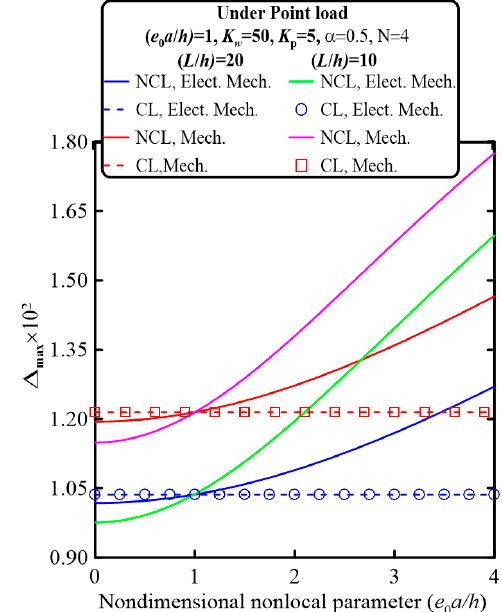
Figure 9. Variation in the maximum normalized transverse deflection Δ max with the nondimensional nonlocal parameter ( e 0 a / h ) for nonclassical and classical electromechanical and mechanical behaviors under uniformly distributed and point loads at different values of the nonclassical and elastic foundation parameters at α = 0.5 and beam aspect ratio L / h = 10, 20, L = 100 nm, N = 4, e 311 = − 4.1 C/m 2 , µ 3111 = 5 × 10 − 8 C/m, a 33 = 7.124 × 10 − 9 C/m 2 K, and K p = 5 and K w = 50.